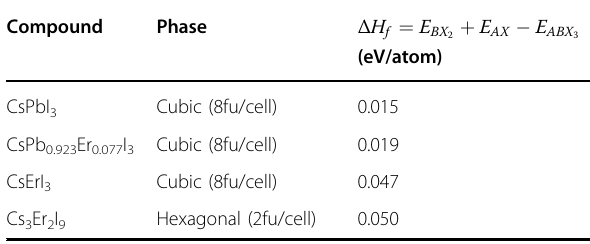
Table 1 Formation energy of ternary compounds (CsPbI 3 , and Er 3 + doped CsPbI 3 ) to binary compounds calculated by using PBEsol